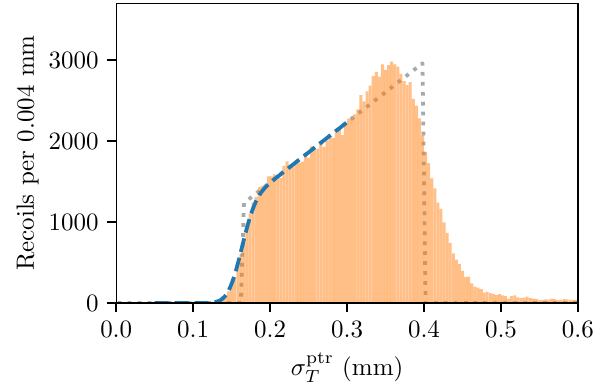
Fig. 15 A histogram of the transverse width σ ptr from the beam-on dataset with E > 100 keV, with a fit to the lead- ing edge (dashed blue line) using Eq. (25) convolved with a Gaussian smearing function. The dotted gray line shows the fitted function over the whole range and without